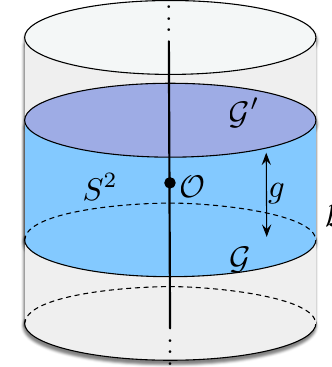
Figure 5 . Left: 3d = 4 theory on C R with a boundary condition N (cid:2) as 1d = 4 quantum mechanics. Right: surrounding a local operator with a topological S 2 that N has been deformed to two closely separated copies of C (the boundary of a cylindrical